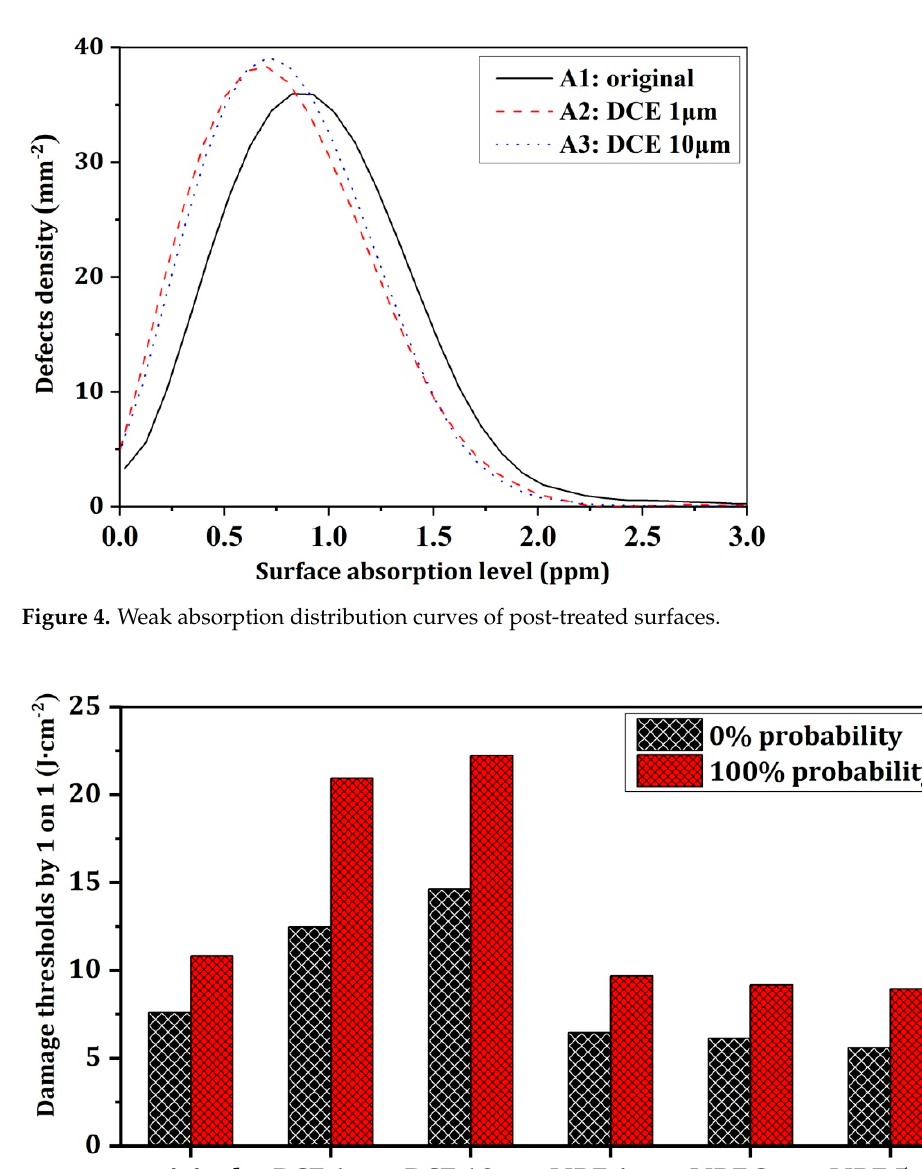
Figure 4. Weak absorption distribution curves of post-treated surfaces.